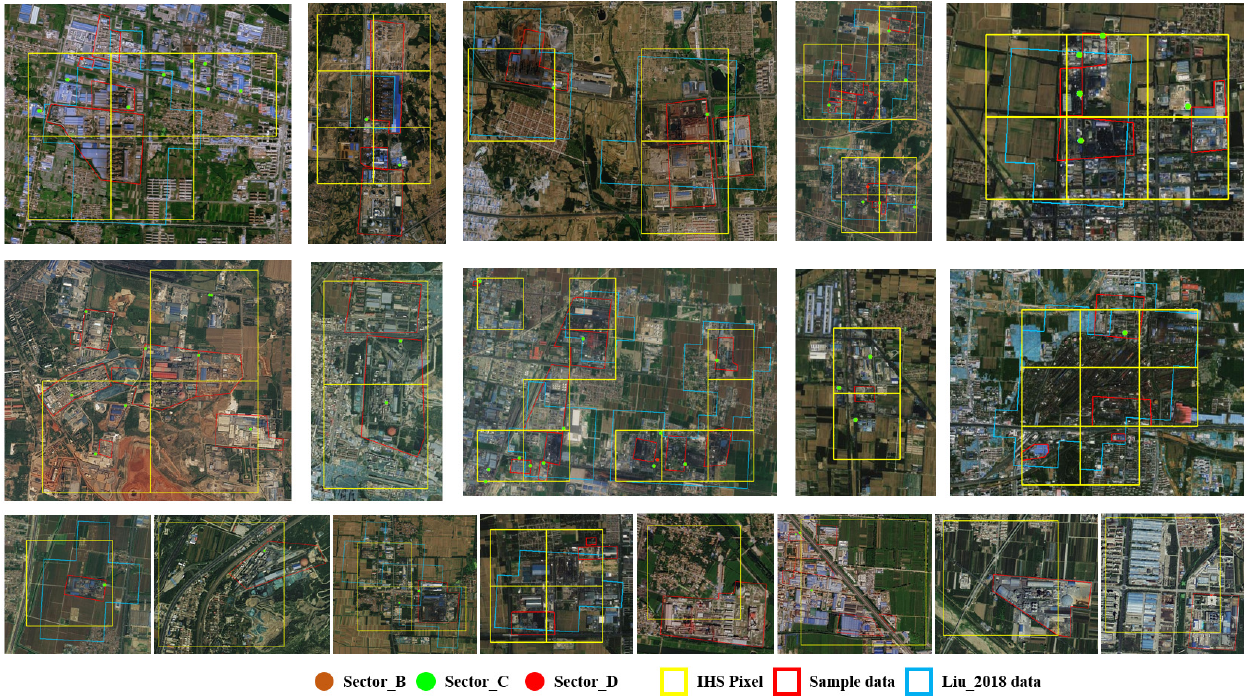
Figure A2. Examples of comparison between the industrial heat source (IHS) pixels of this study and two reference data (i.e., the sample data and Liu_2018 data). The dots represent the corporations falling in IHS pixels.